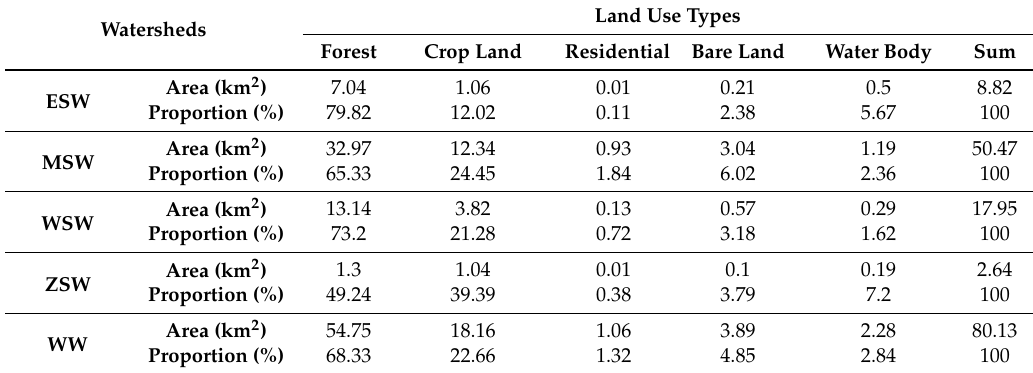
Table 1. Drainage areas and land uses of the Huashan watershed (WW) and its sub-watersheds. ESW means Eastern sub-watershed, MSW for Middle sub-watershed, WSW for Western sub-watershed, and ZSW for Zhuyuangou